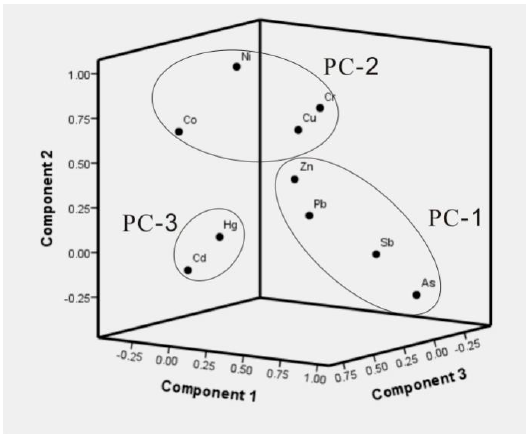
Figure 3. 3D plot of scores for investigated elements obtained from PCA results for street dust of Hezhang